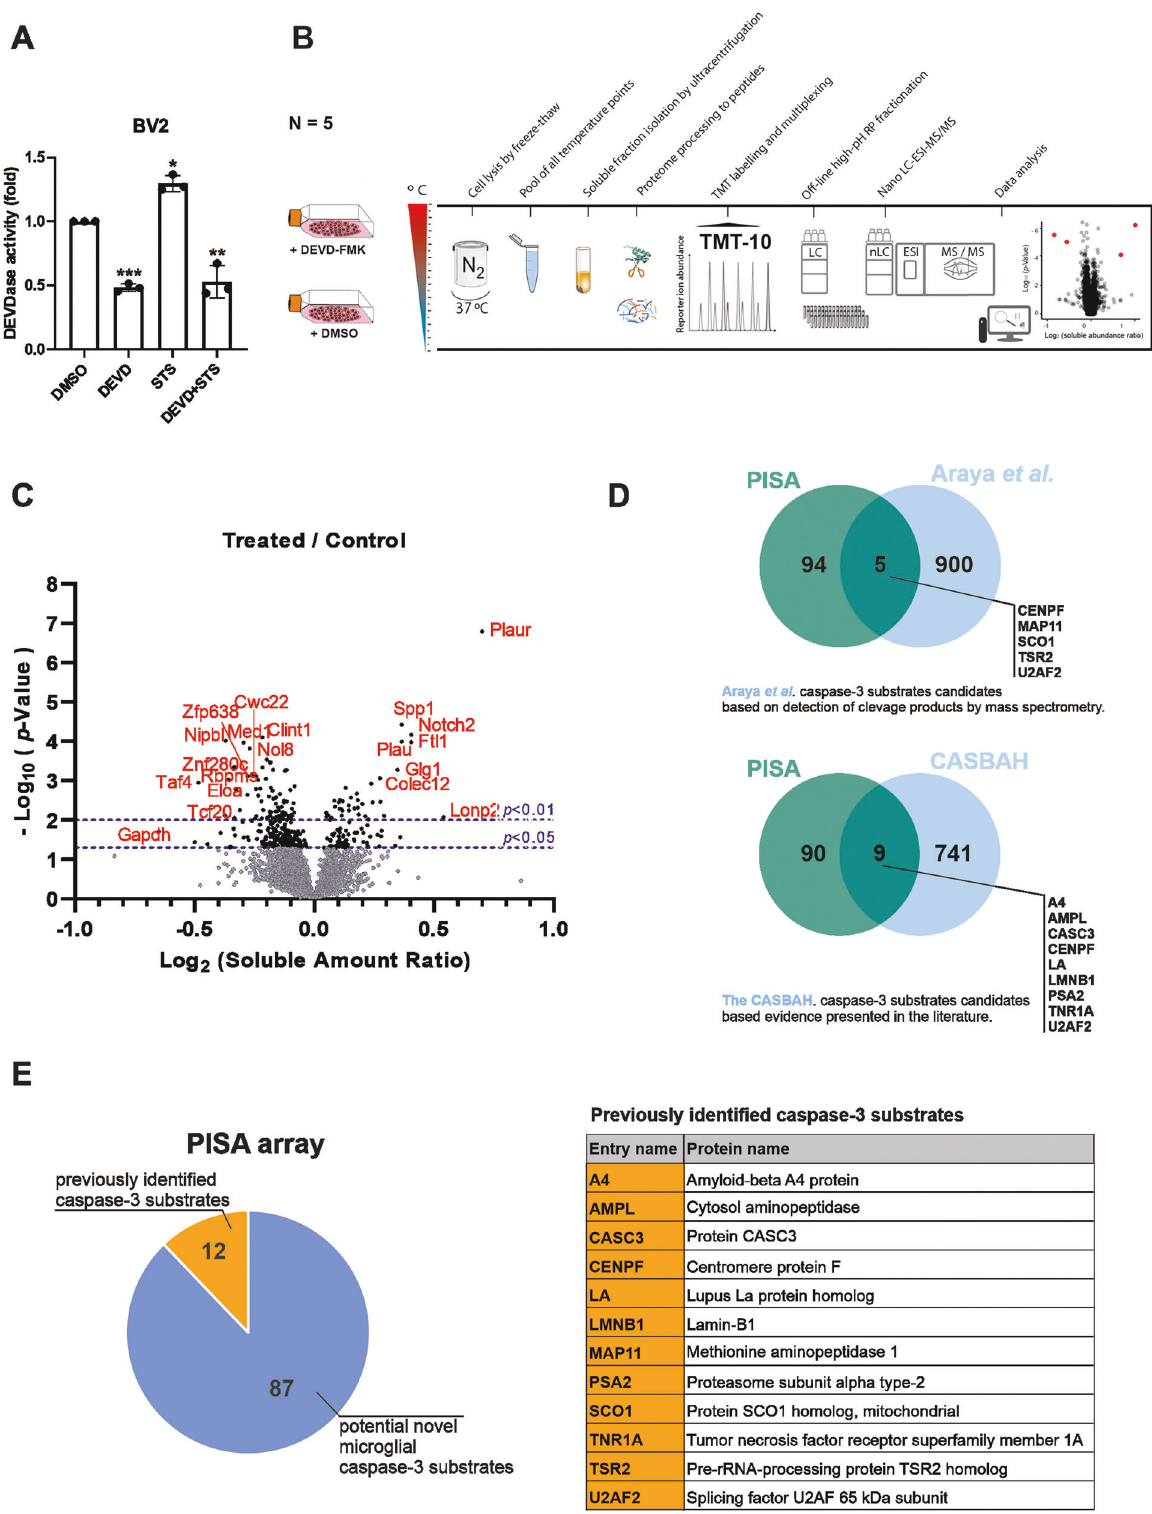
solution and with the events like denaturation or aggregation triggered by the PISA temperature range. Independently from any thermodynamic interpretation of single proteins in the complex molecular matrix of a cell, the proteins affected by the treatment are different in their solubility points at lower or